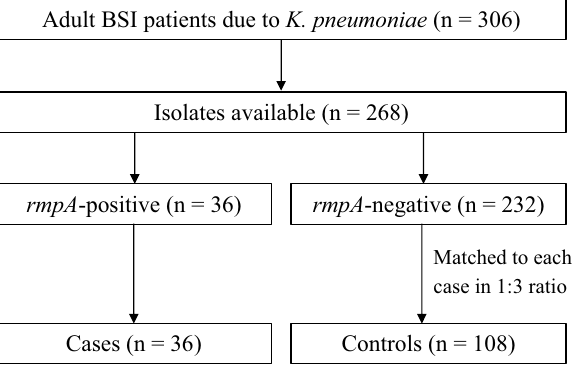
Figure 1. Study design depicting adult patients with bloodstream infection (BSI) and bacterial isolates.